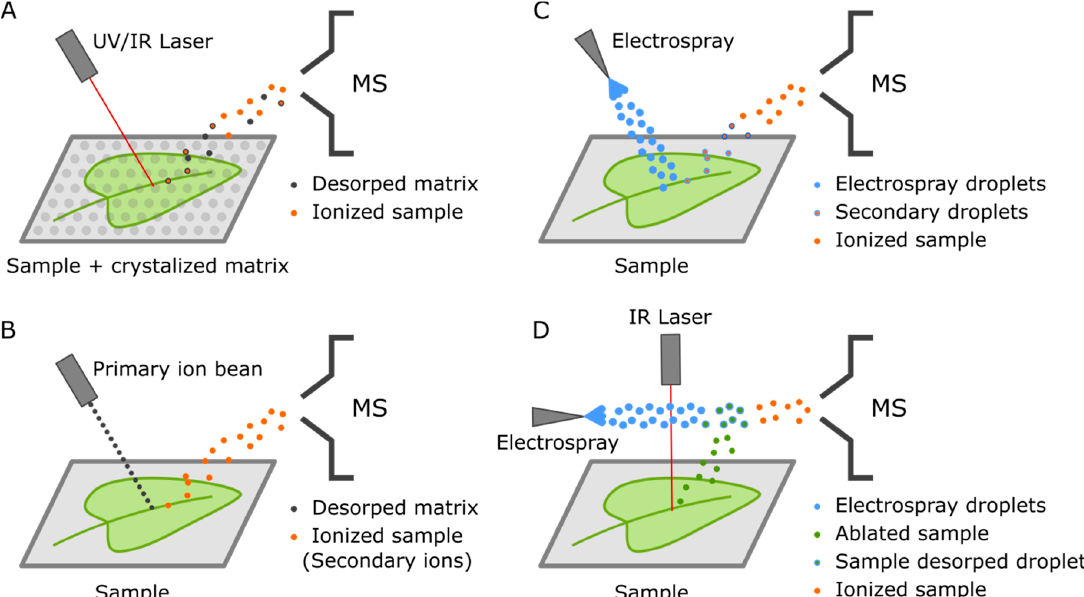
Figure 3. Schematic representation of the different ionization strategies used for mass spectrometry imaging (MSI). ( A ) MALDI, ( B ) secondary ion mass spectrometry (SIMS), ( C ) desorption electrospray ionization (DESI), ( D ) laser-ablation electrospray ionization (LAESI).